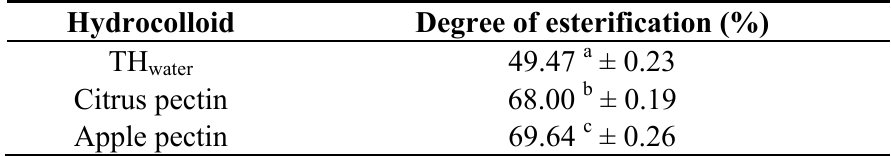
Table 5. Degree of esterification (DE) of tamarillo hydrocolloid (TH pectins measured using FT-IR